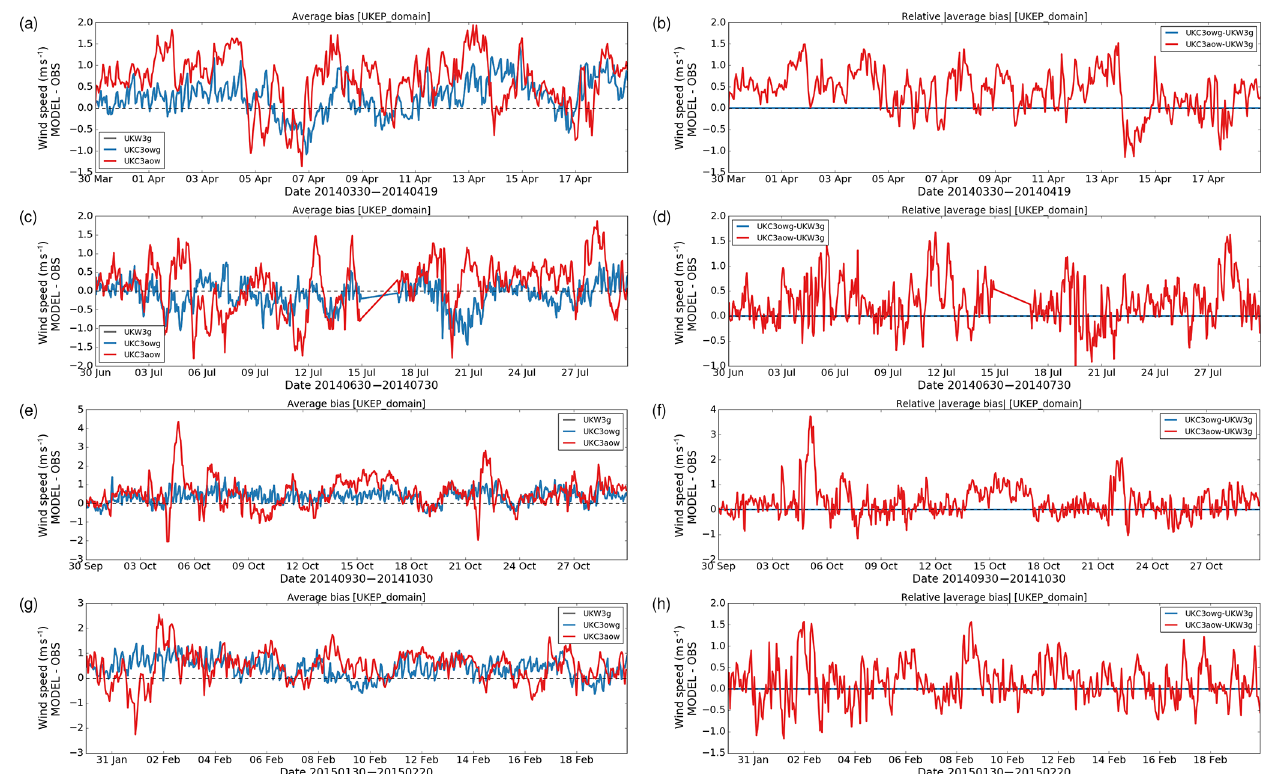
Figure 6. Difference of wind forcing applied to wave model. (a, c, e, g) Time series of average model–observation (MODEL–OBS) bias across all observing sites for each simulation for July, April, October 2014 and February 2015, respectively. (b, d, f, h) Differences in absolute | MODEL–OBS | bias for each simulation period relative to the UKW3g wind forcing. Note that plots have different scales across the different months evaluated, and observations are compared with a nearest neighbourhood mean of 3 by 3 model grid